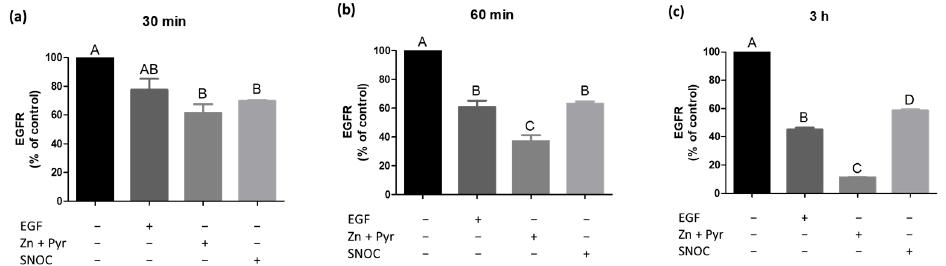
Figure 3. Zinc reduces EGFR surface expression. The effect of EGF (10 ng/mL), zinc (Zn, 50 µM) and pyrithione (Pyr, 0.5 µM) or SNOC (2 mM) on the surface expression of the EGFR is shown. A549 cells were stimulated for 30 min ( a ), 60 min ( b ) or 3 h ( c ) and measurements were performed by using flow cytometry. Data of n = 3 independent experiments are shown as means + SEM. Statistical significances were calculated with one-way Anova and Tukey’s post-hoc test ( p < 0.05). Means not sharing any letter are significantly different (A–D).